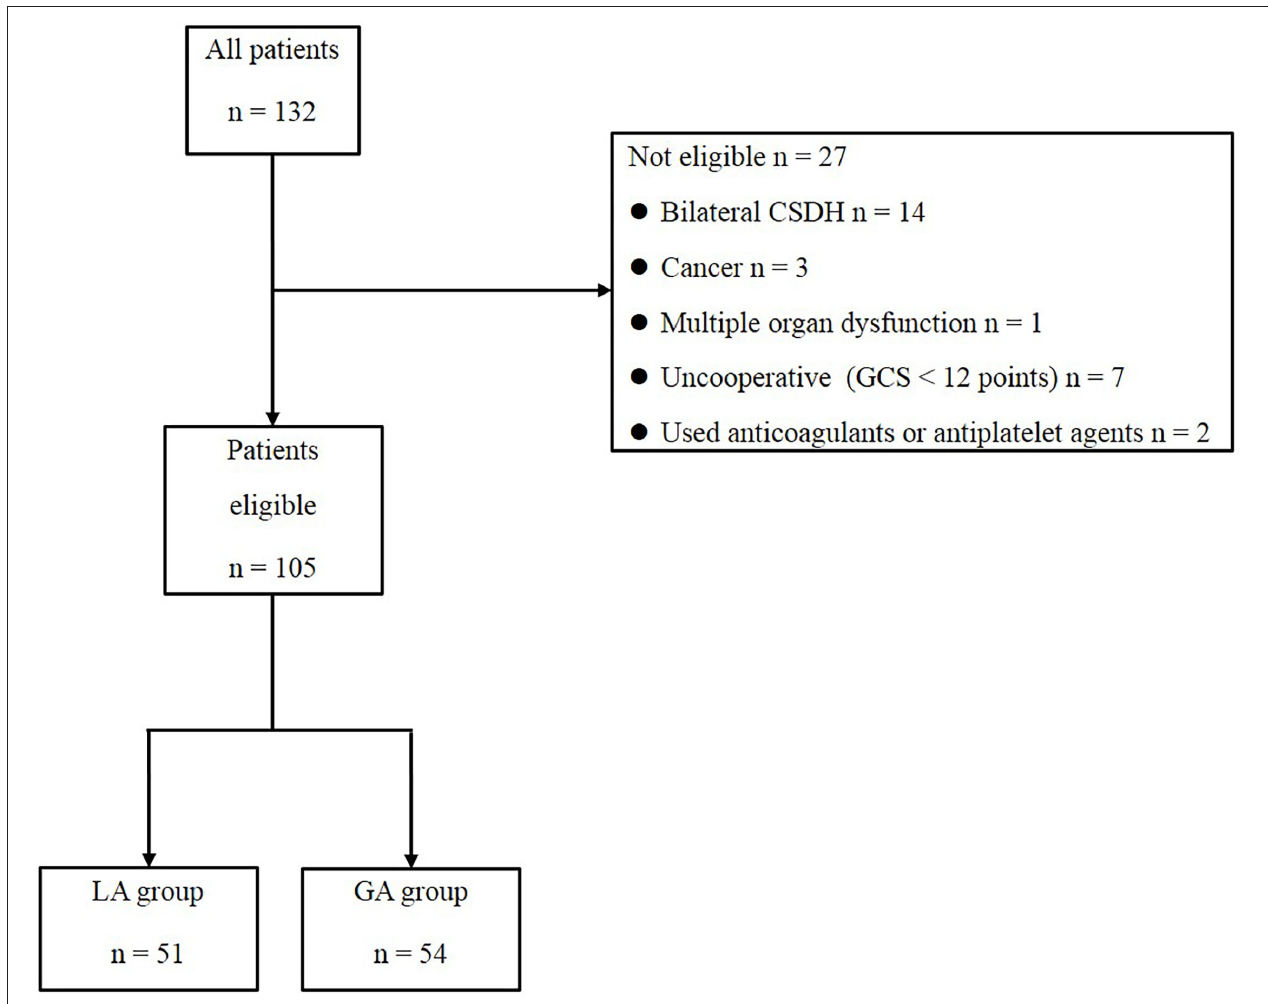
FIGURE 1 | Flow chart for exclusion of